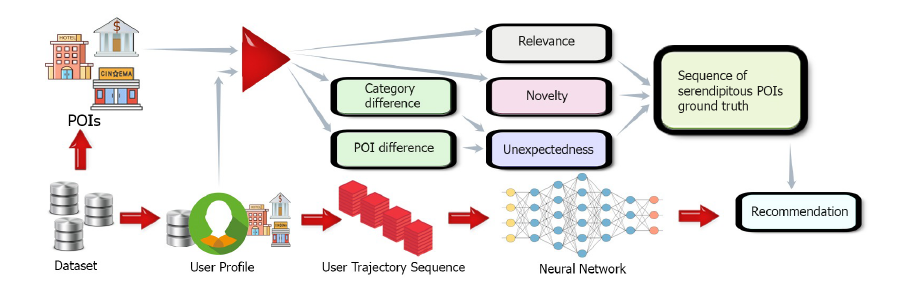
Figure 1. The framework of the